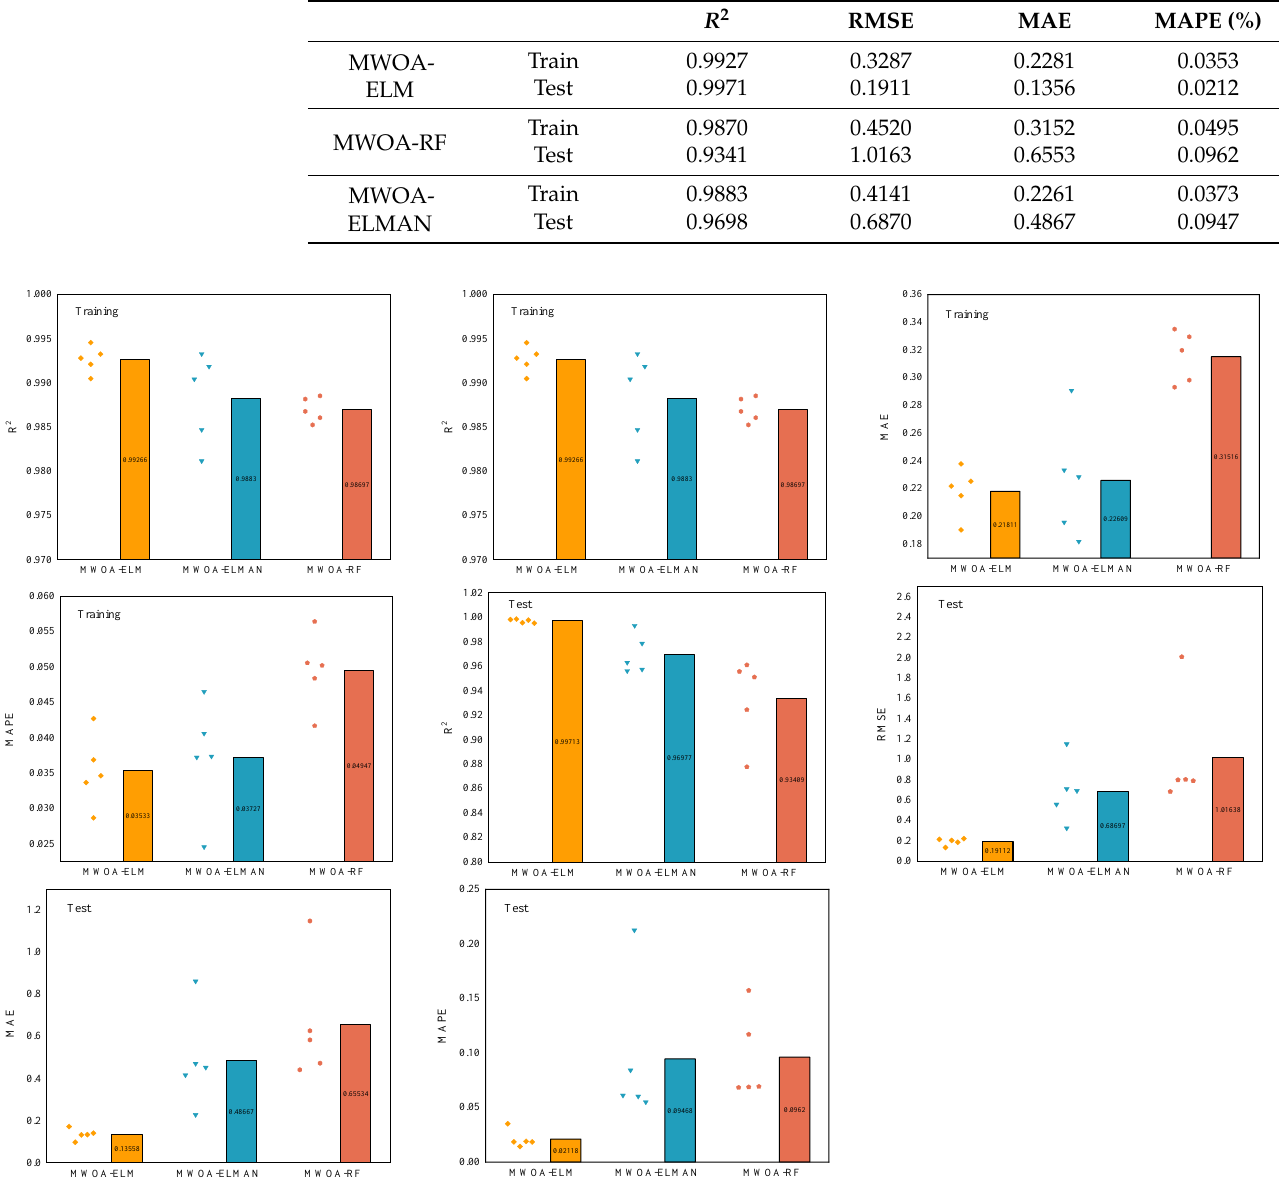
Table 8. Average of evaluation indicators for MWOA-ELM, MWOA-RF, and MWOA-ELMAN.